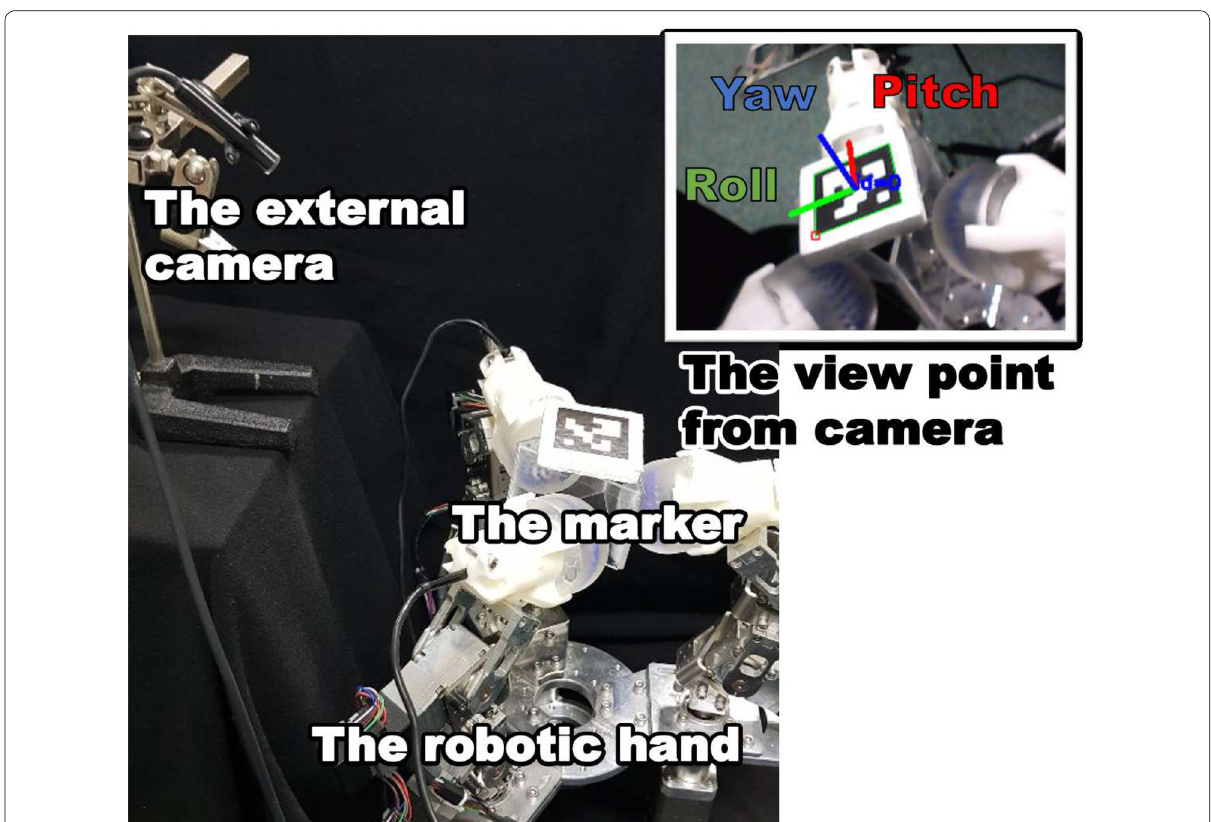
Fig. 18 Experimental setup of the triple‑fingered robotic hand with a grasped object and external camera to detect the position and orientation of the object to evaluate the accuracy of the proposed control